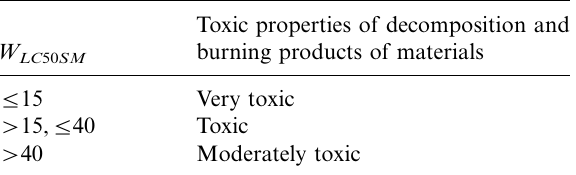
Table 13. Toxic properties of decomposition and burning products of